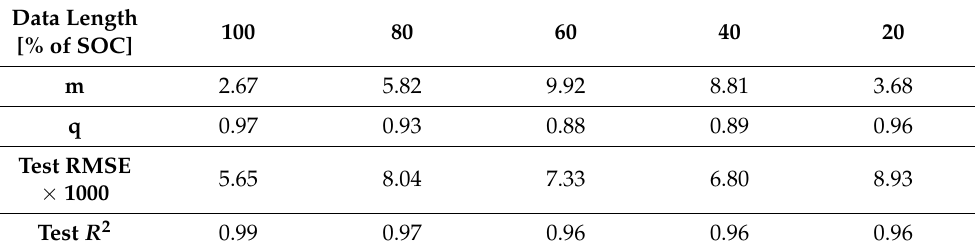
Table 3. Analysis #1: Best neural network regression statistics.